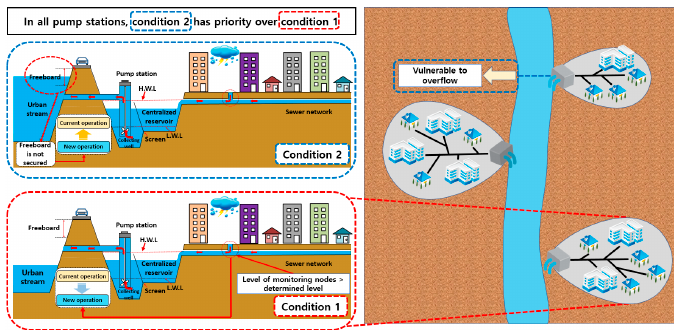
Figure 1. A schematic of integrated operation in urban areas. LWL, low water level; HWL, high water level.